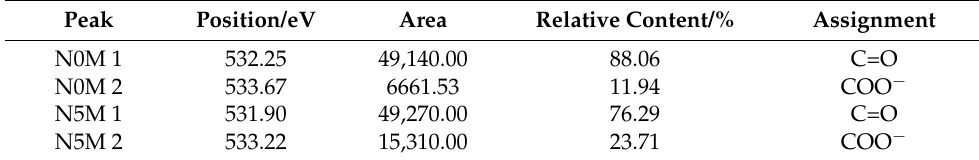
Figure 9. XPS O1S spectra for lignite and nitric acid-modified lignite. Table 5. XPS O1S synthesized data of lignite and nitric acid-modified lignite. Peak Position/eV Area Peak